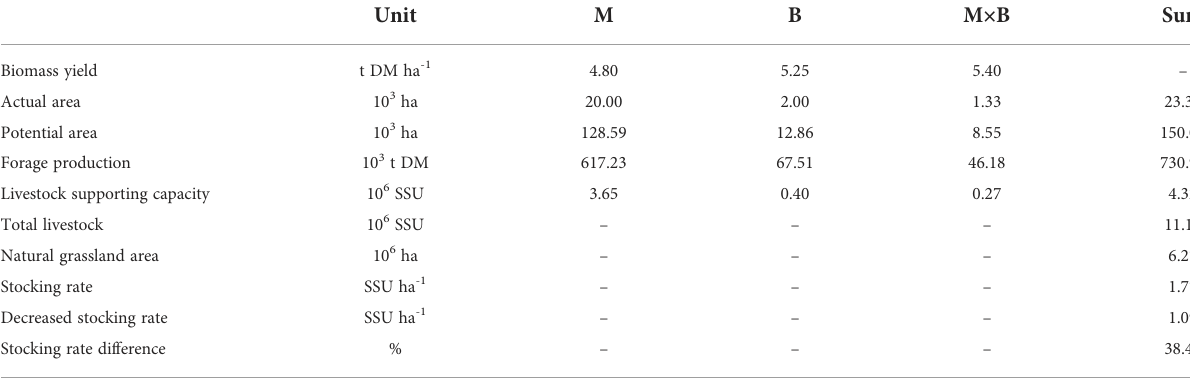
TABLE 6 The potential effect of sown pastures on the stocking rate of the natural grasslands of Hulunber in 2020. Unit